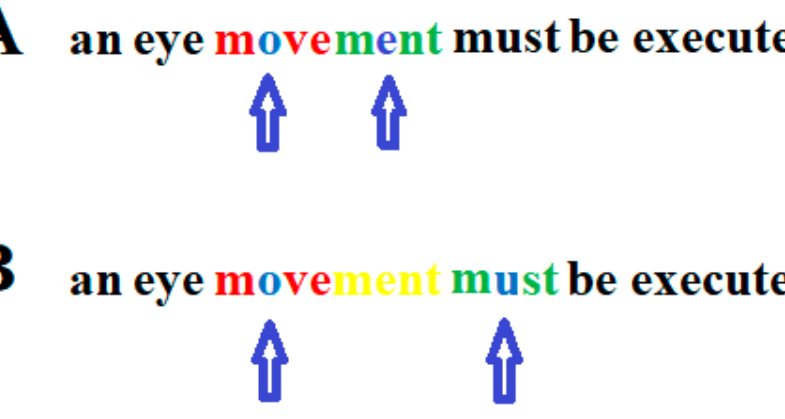
Figure 2. Correct ( A ) and too large ( B ) saccade during reading. In the upper graph, the arrows indicate on which letter within a word segment a person who can only recognize four letters simultaneously must focus his/her gaze. One letter to the left and two letters to the right (red) of the focused letter (blue) must be recognized simultaneously together with the focused letter. After the first word segment (blue and red) has been read, the gaze only moves so far in the reading direction that the next word segment to be read (blue and green) follows without a gap between the two word segments. ( B ): After the first word segment (blue and red) was read, the eyes jumped too far to the next word segment (blue and green) so that the letters “ment” (yellow) were overlooked. Arrows indicate the letter on which the gaze is focused.